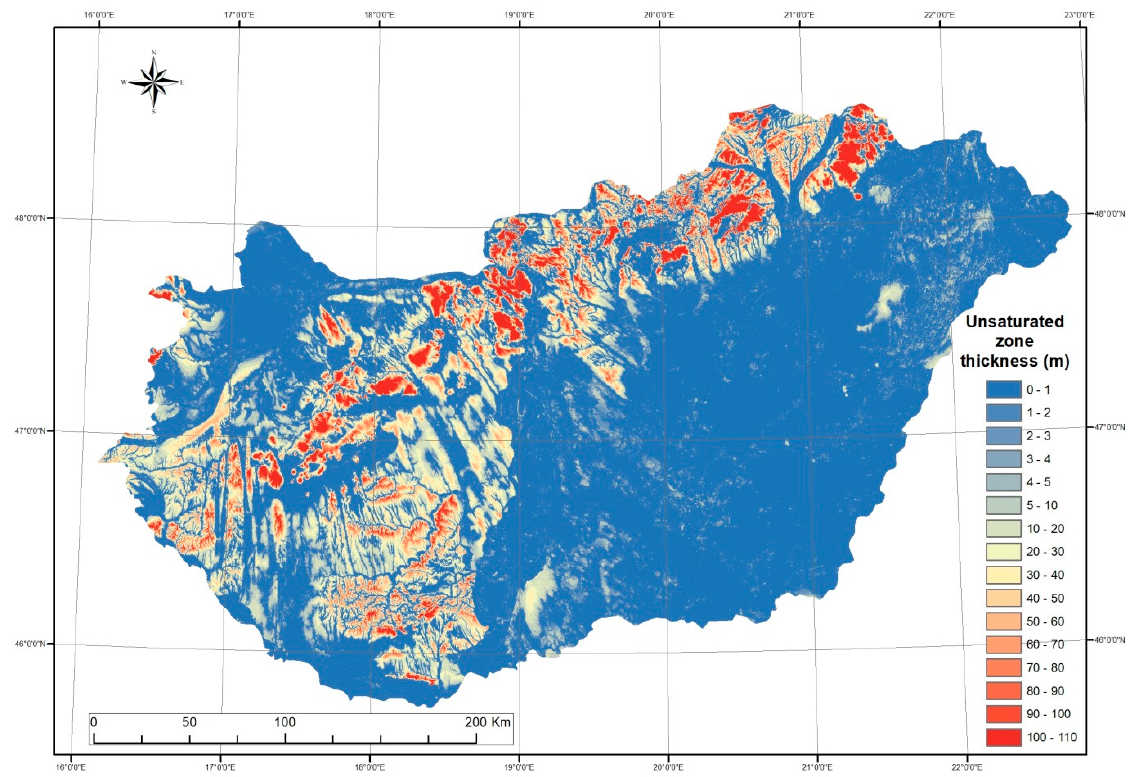
Figure 16. Simulated unsaturated zone thickness map: 1961–1965 average conditions.